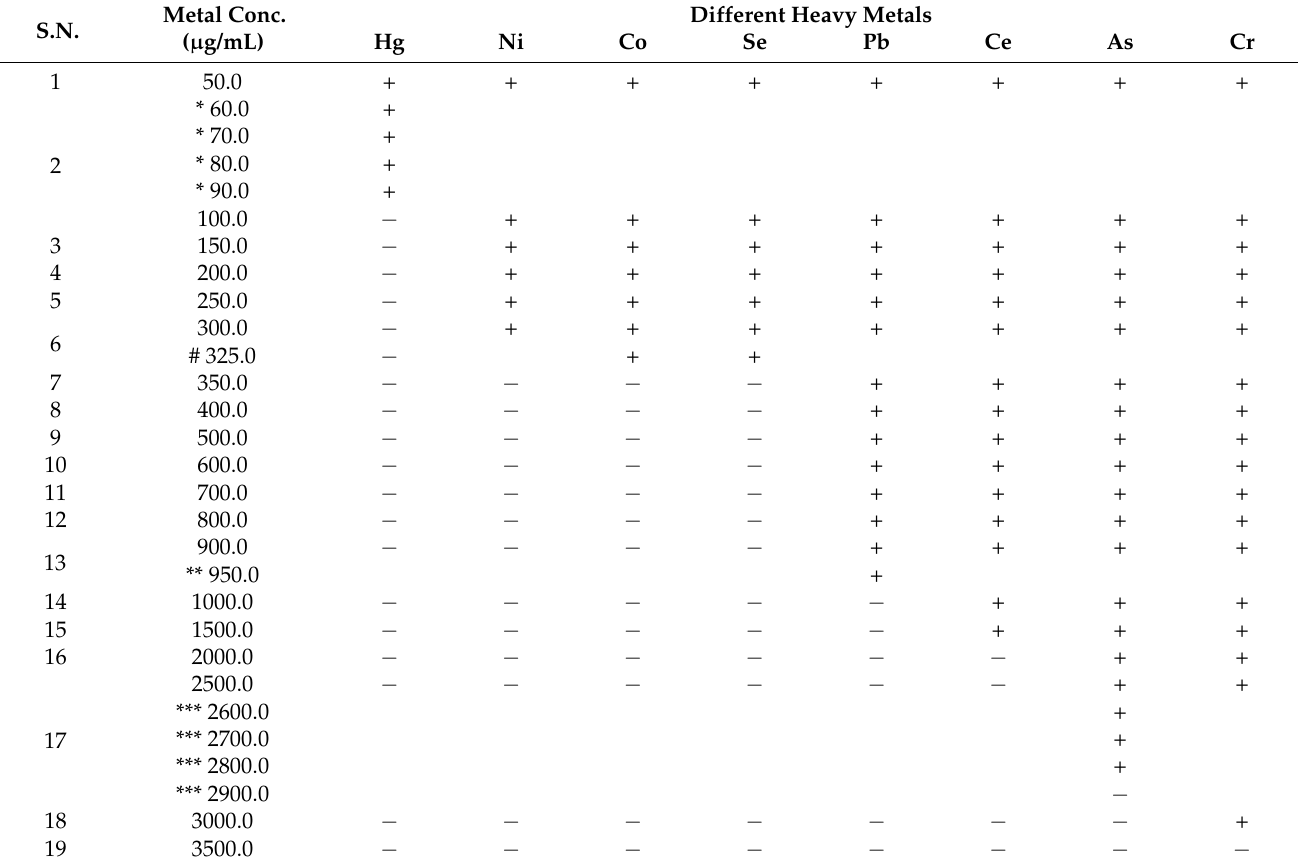
Table 1. Heavy-metal-resistant pattern system.